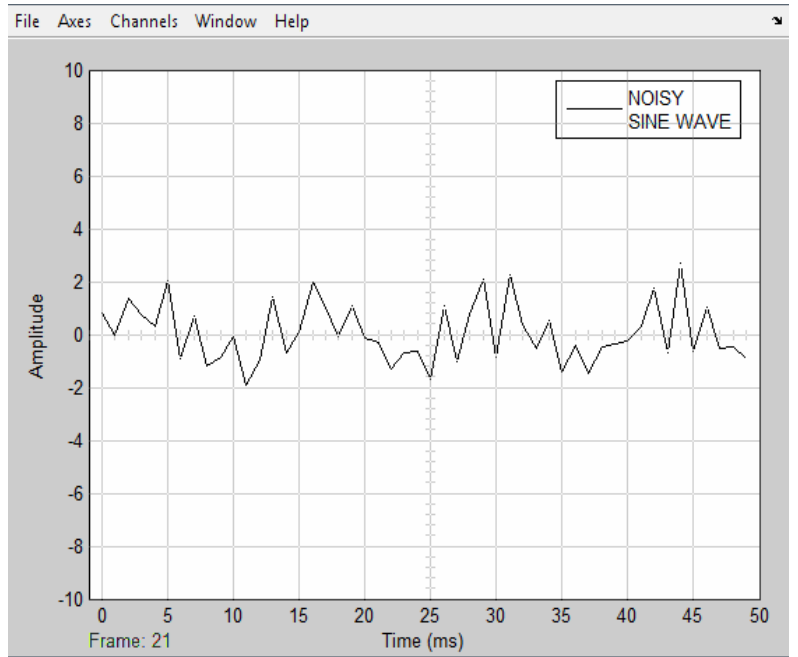
Figure 9. The noisy sine wave used in the Simulink model .